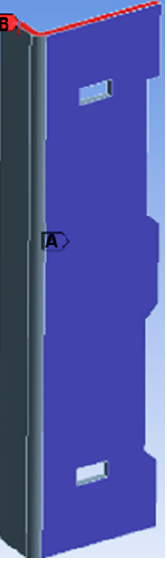
Figure 5. Support subjected to random vibration fatigue.